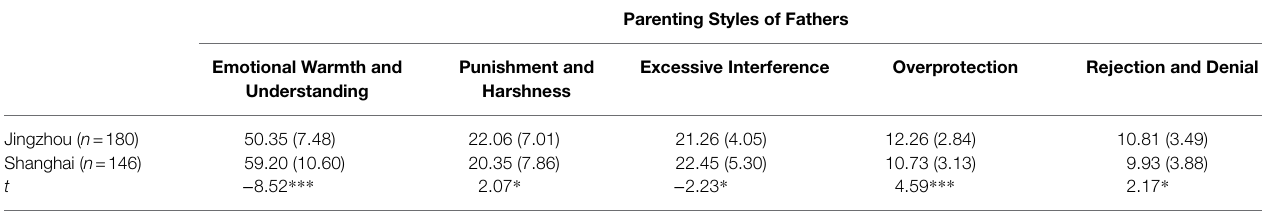
TABLE 2 | Comparison of differences in parenting styles of primary school students’ fathers in different regions M (SD).